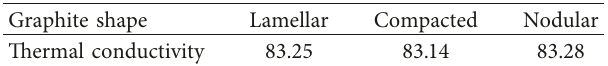
Table 1: Calculation values in different graphite morphologies (W/m · K).